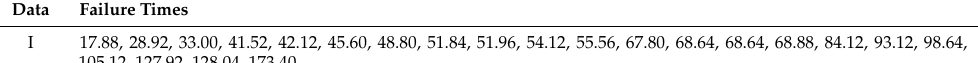
Table 1. Ordered lifetime data of ball bearing and March precipitation.